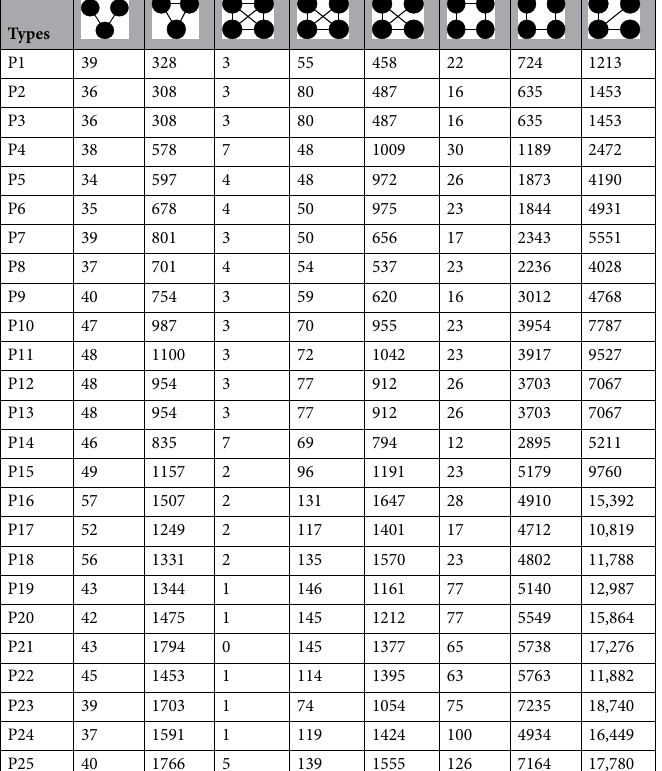
Table 3. Number of each (anti-) motif in the 25 product structural